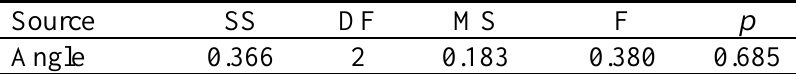
Table 10. ANOVA TP results for teach pen